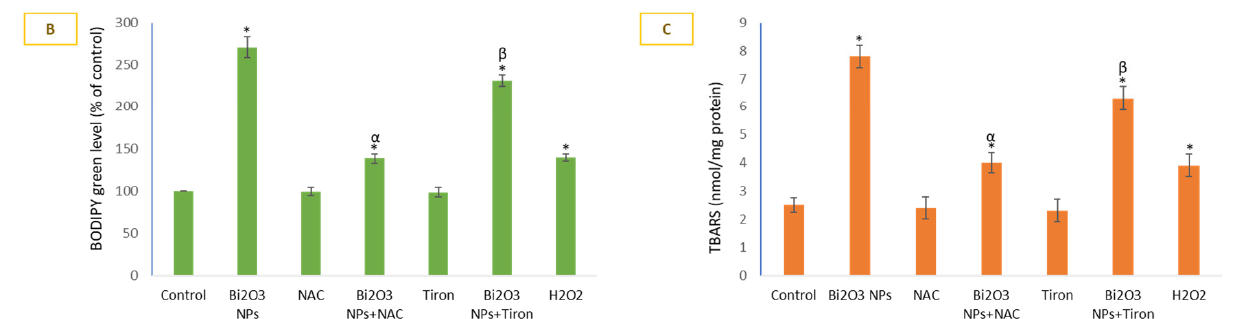
Figure 3. Lipid peroxidation (LPO) was detected using live-cell imaging dye ( A ) that preferentially localizes in a hydrophobic environment and fluoresces green in proportion to LPO. BODIPY green fluorescence was calculated in ImageJ software ( B ). LPO was also assessed by a more conventional method by quantifying TBARS spectrophotometrically ( C ). Data represented are mean ± SD of three identical experiments ( n = 3) conducted in triplicates. * Statistically significant difference compared to the controls ( p < 0.05). Any significant ( p < 0.05) difference in response from that mediated by NPs and the addition of either NAC or Tiron is denoted by α and β , respectively.